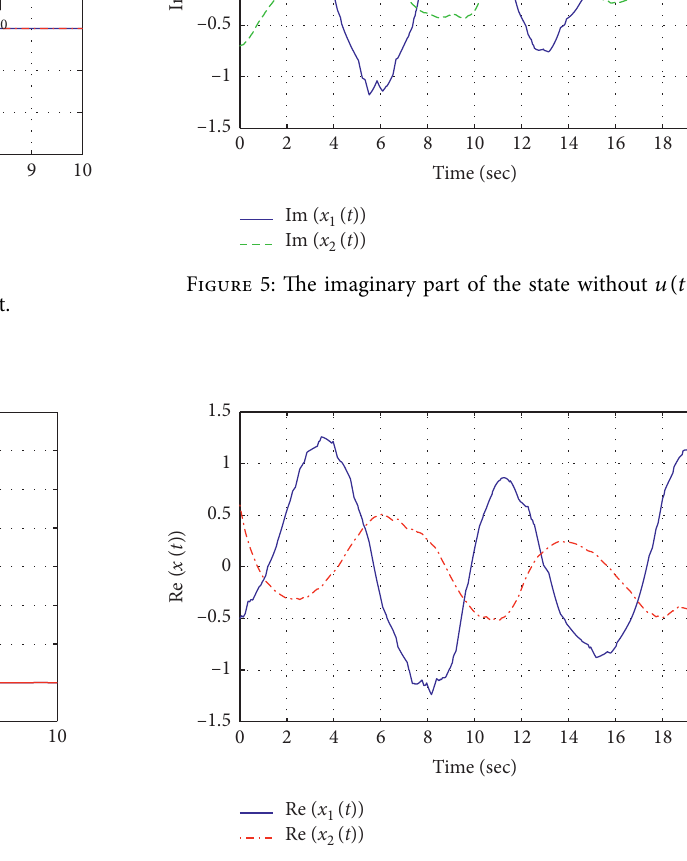
Figure 6: The real part of the state without u ( t ) .